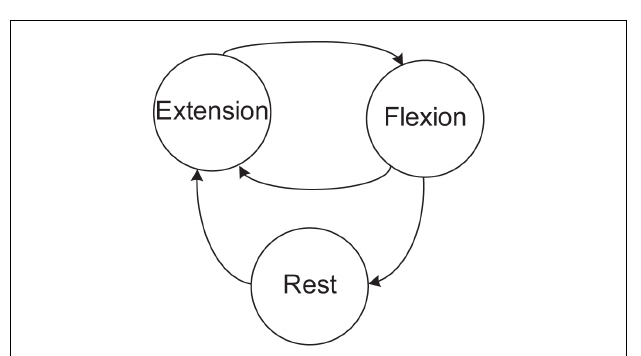
FIGURE 4 |A diagram of possible state transitions for finger